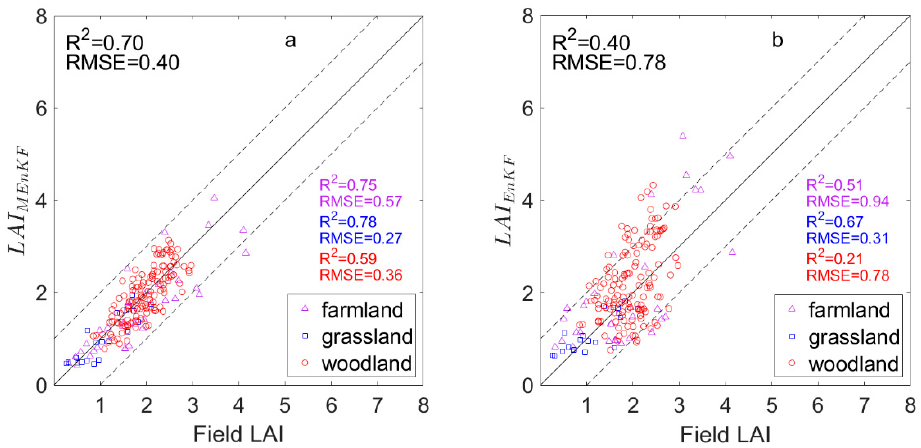
LAI and ( b ) MEnKF and ( b ) LAI EnKF MEnKF